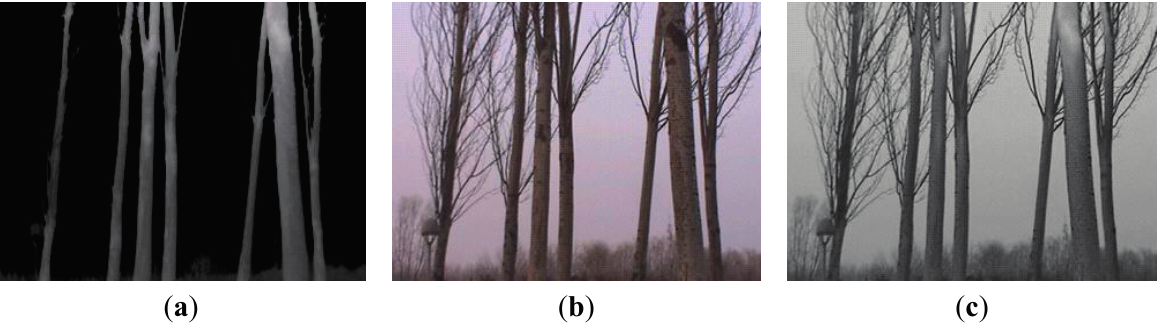
Figure 2. The raw laser data scanning result.